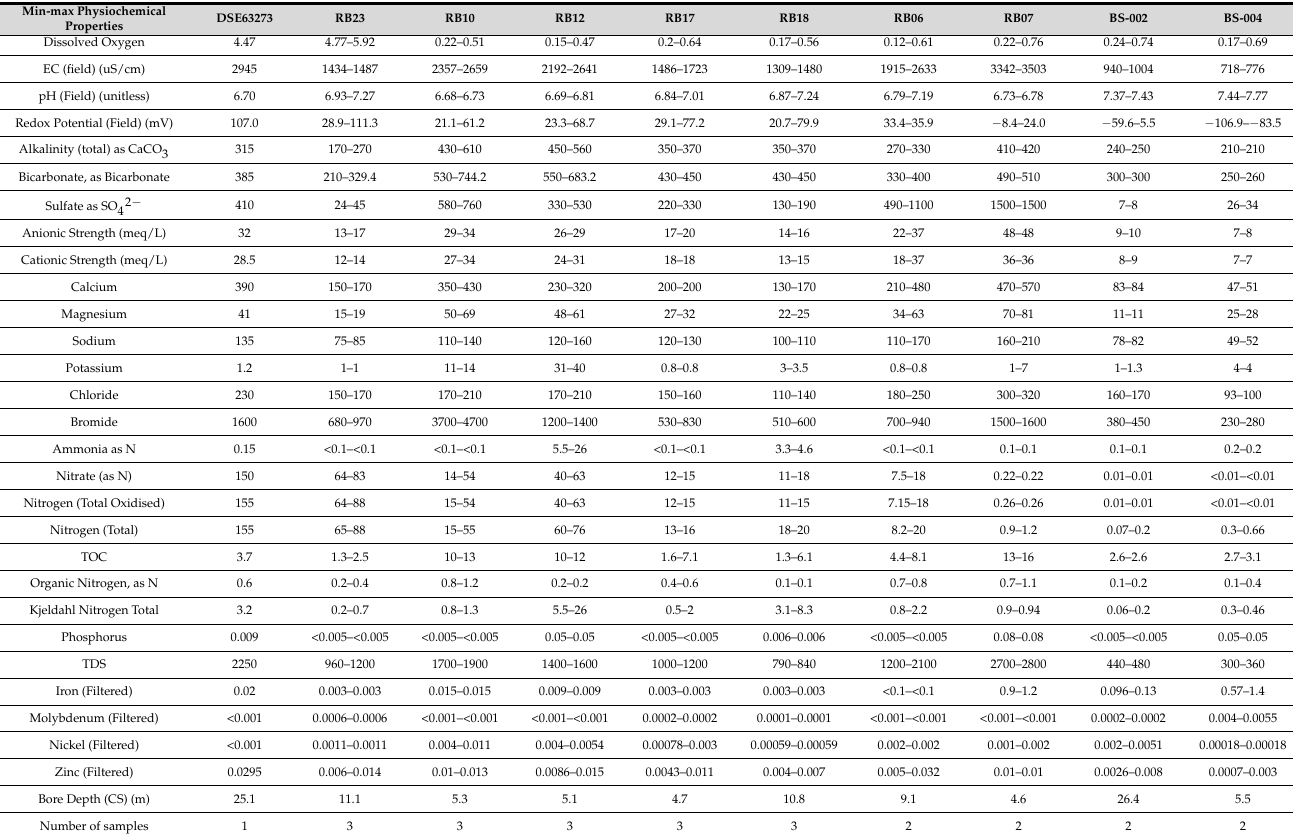
Table 1. The physiochemical ranges and values of the ten groundwater wells sampled for this project. Units in mg L − 1 unless otherwise